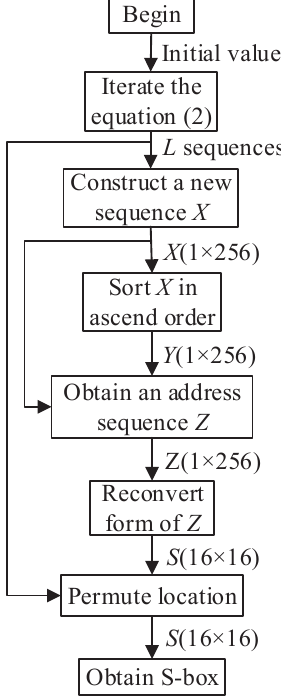
Figure 4. The flowchart of the construction process of the obtained